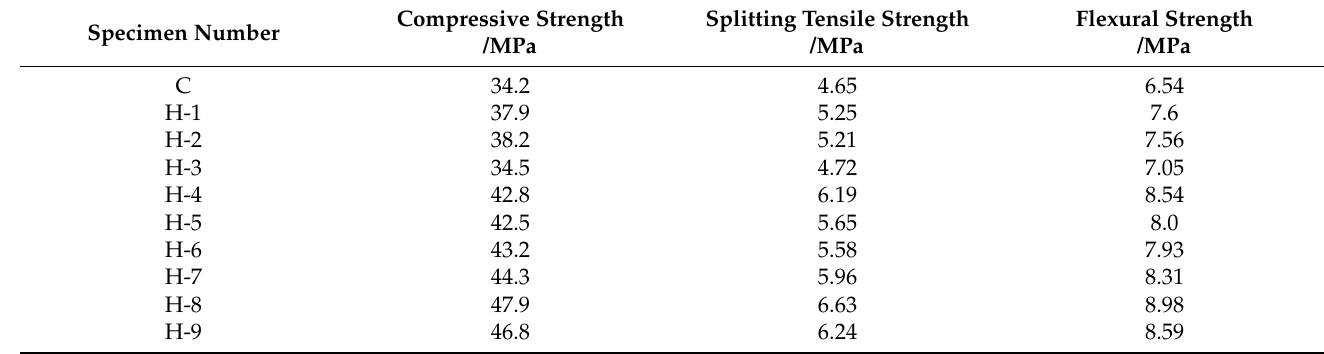
Table 4. Test results of compressive strength, splitting tensile strength and flexural strength of each group of specimens. Specimen Number